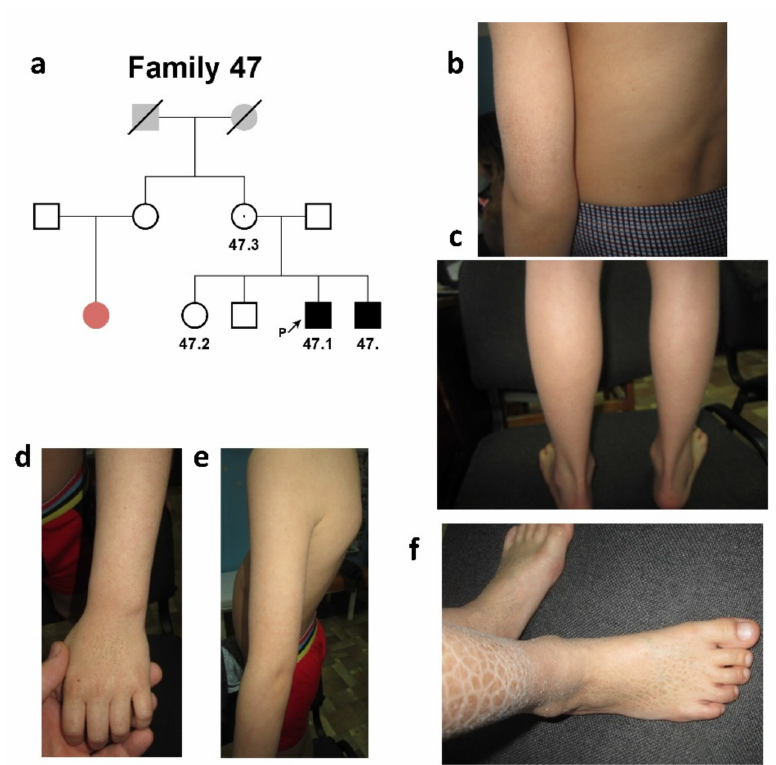
Figure 2. Family #47. ( a ) Three-generation pedigree #47 was presented by two affected siblings (#47 and #47.1). Probands’ female cousin was affected with palmoplantar hyperkeratosis (colored with pale red in the pedigree); ( b , c ) photo of patient #47.1. Small grayish-brown scales (2–5 mm in size) on the surface of the back and forearm ( b ), large dark scales (12–17 mm in size) on the lower back surface of the legs ( c ); ( d – f ) photo of patient #47. Grayish-brown scales of small size on the back and forearm ( d , e ) and larger scales on the legs ( f